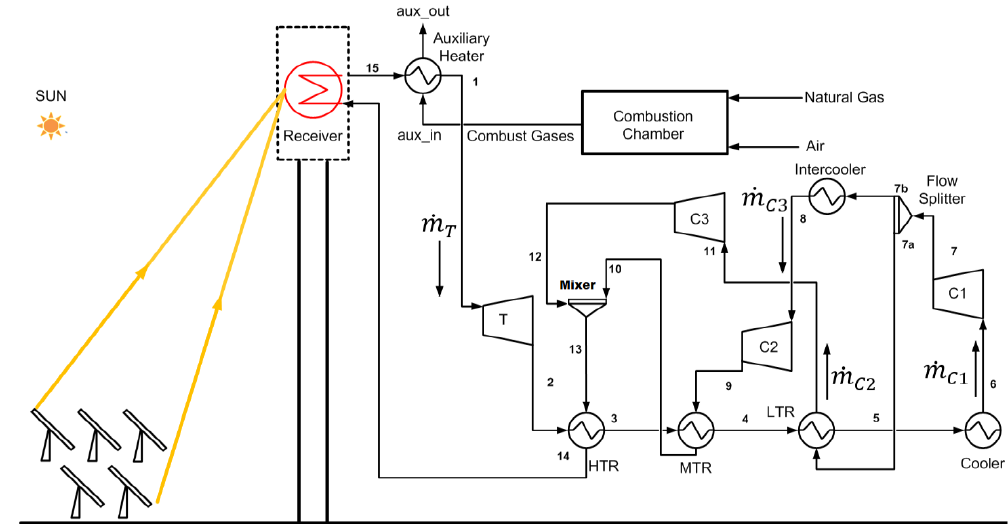
Figure 1. Layout of the solar powered S-CO 2 Brayton cycle integrated with an auxiliary heater to maintain a constant net power output from the cycle. T, C1, C2, C3, HTR, MTR and LTR represent the turbine, compressor 1, compressor 2, compressor 3, high temperature recuperator, medium temperature recuperator and low temperature recuperator, respectively.